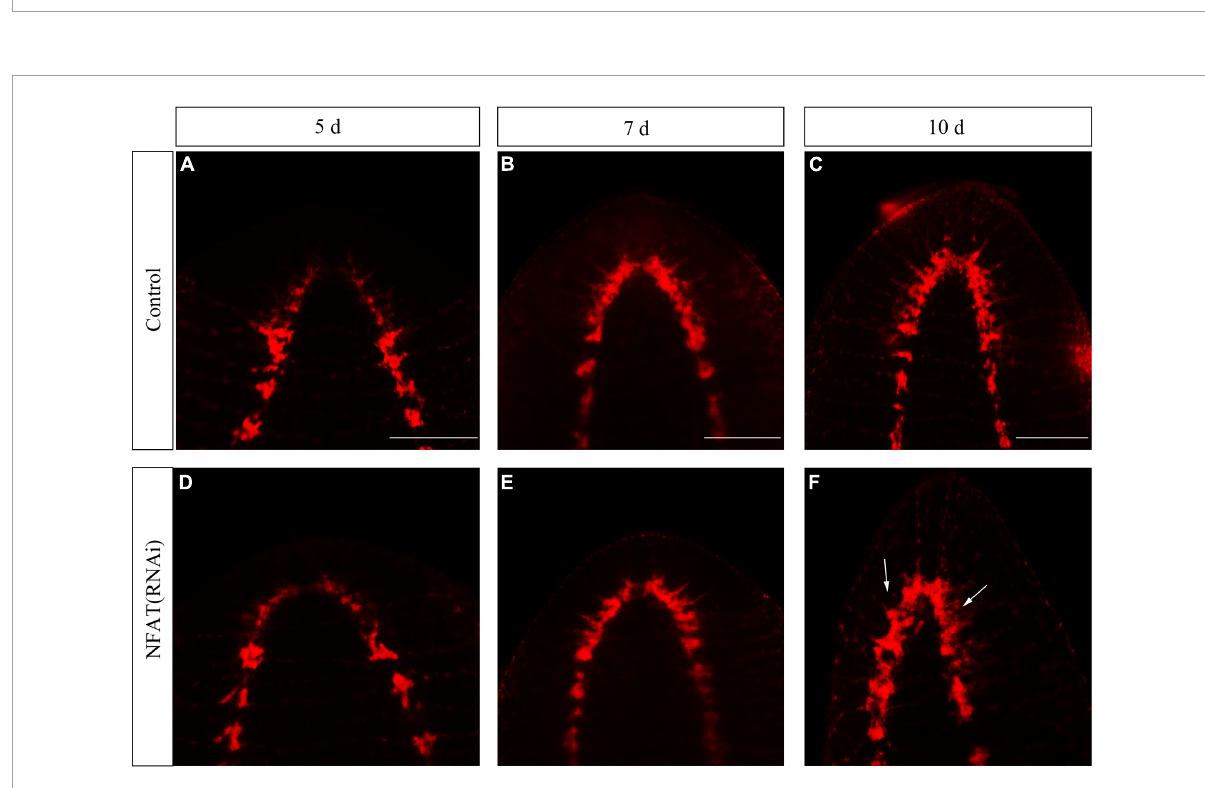
FIGURE6 Immunostaining with anti-SYNORF1 in DjNFAT (RNAi) treated planarians during planarian head regeneration. (A–C) Normal regenerated brains (control), n = 5. (D–F) The phenotypes of the regenerated brain in the DjNFAT (RNAi) treated planarians at 5, 7, and 10 days after amputation, n = 6. Anterior is at the front. Scale bars: 0.5